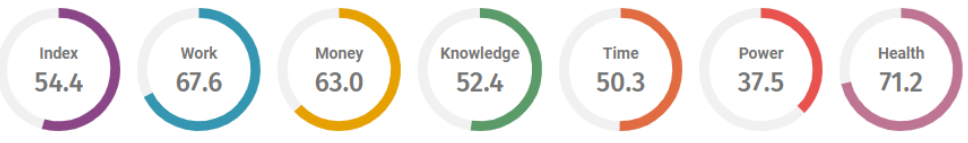
Figure 1. Progress on gender equality in Romania since 2010. Source: EIGE, 2020. Nevertheless, Romania is progressing towards gender equality, albeit at a slower pace than the other EU Member States [19]. One of the elements that holds back progress is the time spent on care activities that have increased over the past 20 years. Women spent more time caring for children, grandchildren, the elderly, or people with disabilities than they did in 2010. This gap is the most significant gender gap in the EU. In addition, the gender gap in the full-time employment rate between single women and men and couples with children is tremendous [19]. Opposite, a positive aspect is the distribution of income between women and men, which became more even between 2007 and 2018. The gender pay gap is currently 4% in Romania, the lowest in the EU [19].